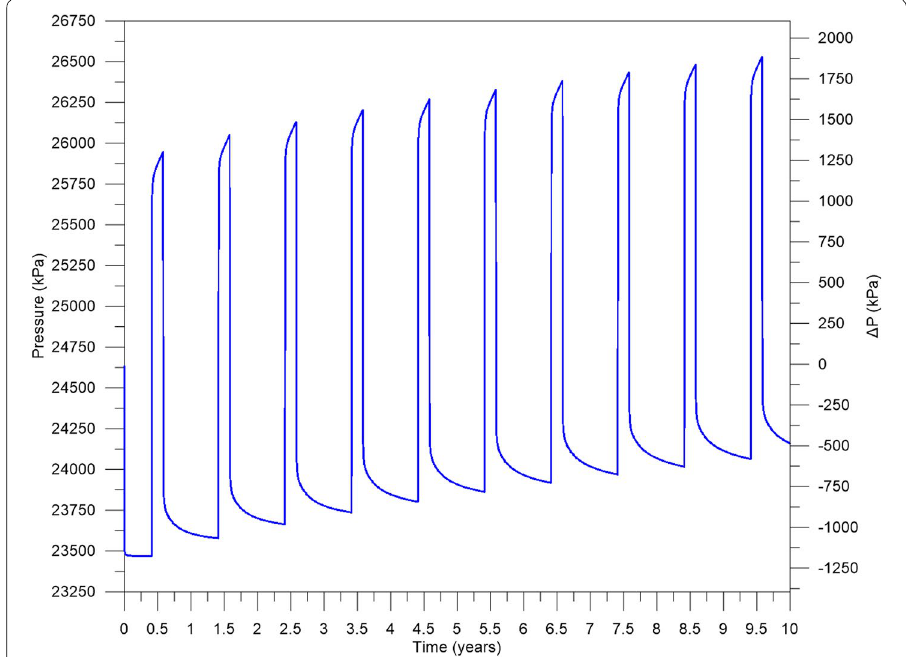
Fig. 7 Pressure history in P1 during a 10-year simulation with annual storage phase of 2 months when I1 was shut